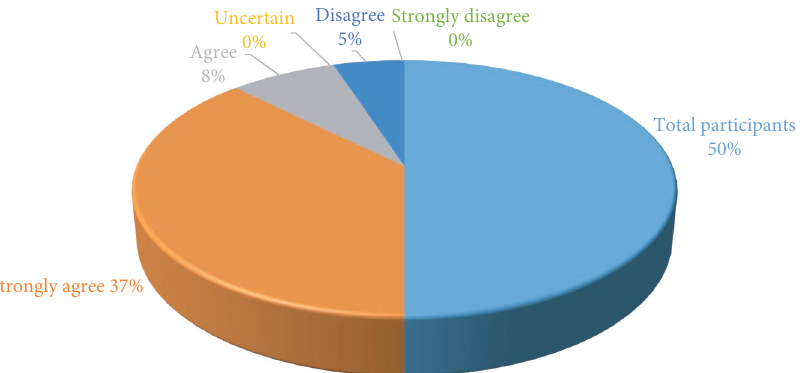
Figure 21: Easiness in terms of